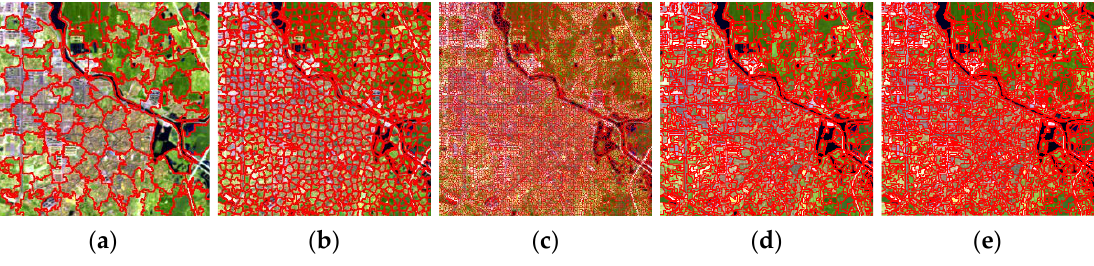
Figure 2. ( a ) Segmentation result of SLIC ( N = 100) ( b ) Segmentation result of SLIC ( N = 1000) ( c ) Segmentation result of SLIC ( N = 10,000) ( d ) Result of merging 20,000 superpixels into 2000 objects ( e ) Result of merging 20,000 superpixels into 4000 objects.